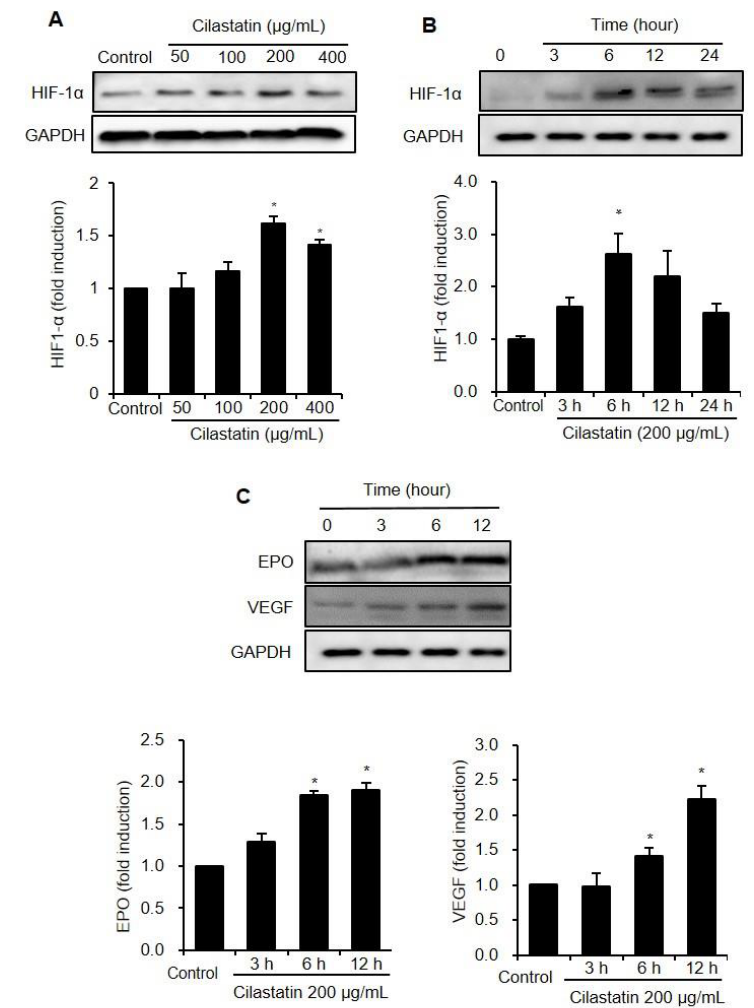
Figure 1. Cilastatin treatment upregulated the expressions of HIF-1 α and its downstream pathway in HK-2 cells. ( A ) Semiquantitative immunoblotting revealed upregulation of HIF-1 α expression by cilastatin treatment in a dose-dependent manner. ( B ) Semiquantitative immunoblotting revealed upregulation of HIF-1 α expression by treatment with 200 µ g / mL cilastatin in a time-dependent manner. ( C ) The expressions of VEGF and EPO proteins, determined by semiquantitative immunoblotting, were significantly elevated by treatment with 200 µ g / mL cilastatin in a time-dependent manner as compared to untreated control. The data are presented as means ± SEM. * p < 0.05 vs. control.